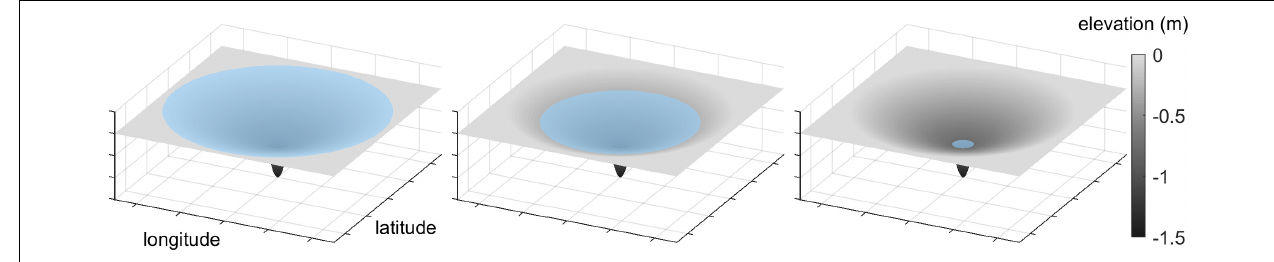
FIGURE 3 | Dynamic water depths within pond basin through time from largely flooded to drying down such that only the permanent pond has water.